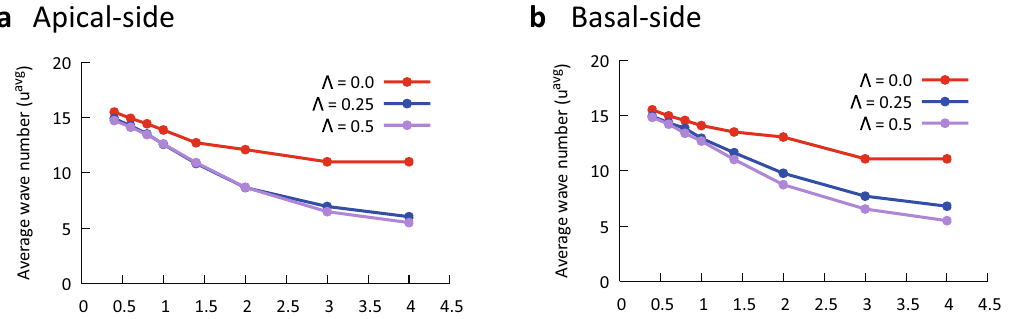
Figure 4. Relation between average wavenumber u avg and the sum of distances between the cell sheet surfaces and walls l sum . The upper right legends show the degree of asymmetry (cid:31) . ( a ) Apical-side results. ( b ) Basal-side results. The smaller the sum of distances between the sheet and walls, the smaller the average wavenumber of the folding. This is generally the case for the apical and basal